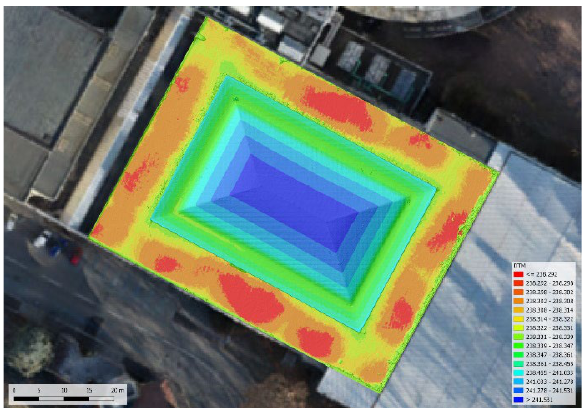
Figure 13 . The UAV photogrammetric DSM superimposed to orthophoto, with range scale colour enlightening the flouage deformation areas on the extrados of the corrugated